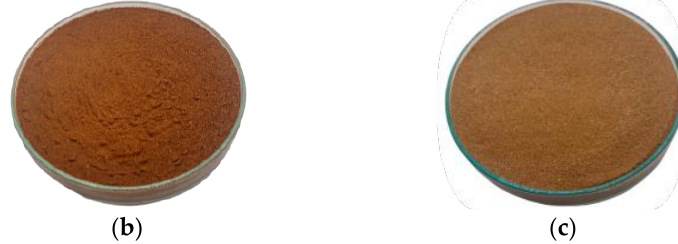
Figure 1. Contaminated soil sample where ( a ) is the saturated soil sample with the commercial grade diesel B7, ( b ) the unsaturated soil sample with the commercial grade diesel B7, and (c ) is the pro- cessed soil sample without the commercial grade diesel